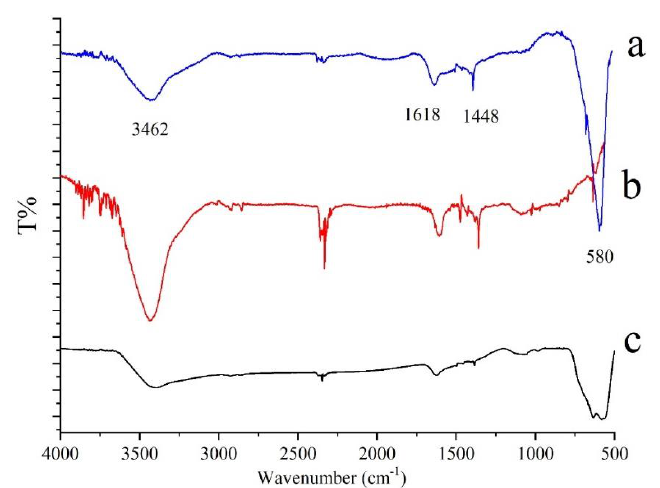
Figure 5. FT-IR spectra of Fe 3 O 4 ( a ), and MWCNTs ( b ) and mag-MWCNTs ( c ).